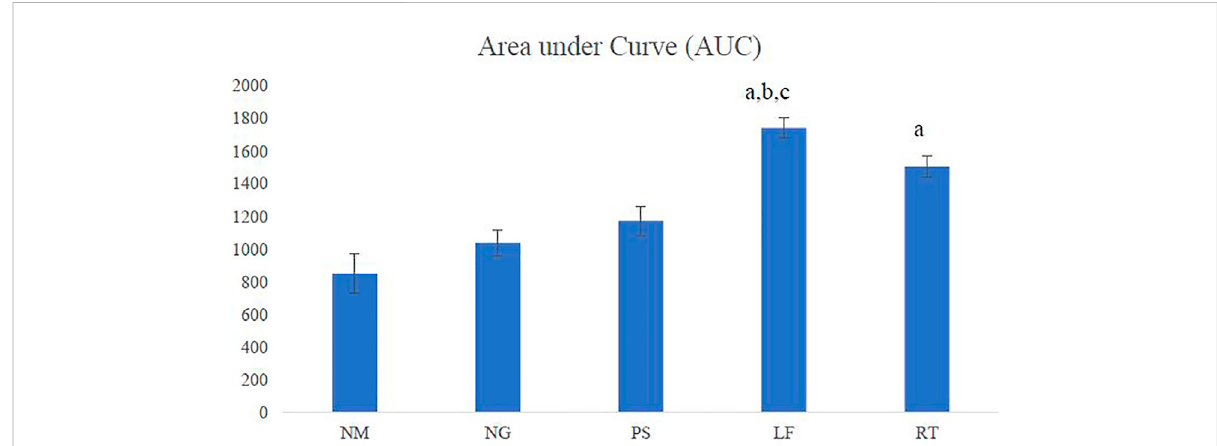
FIGURE 5 Areaunderthecurve(AUC).NM:normalcontrolgroup,NG:negativecontrolgroup,PS:positivecontrolgroup,LF:LPValeaf-treated group,RT: LPVaroot-treatedgroup.DatawereexpressedasAUC±SEM.Statisticallysigni fi cantresultswereindicatedas (A) p ≤ 0.05comparedtoNMgroup, (B) p ≤ 0.05 between NG group, (C) p ≤ 0.05 compared to PS group.